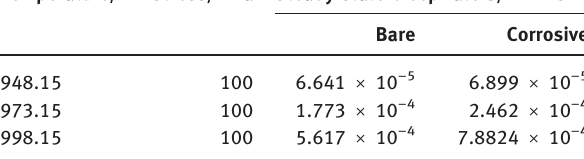
Table 3: Steady-state creep rates of bare and corrosive specimens at different temperature.